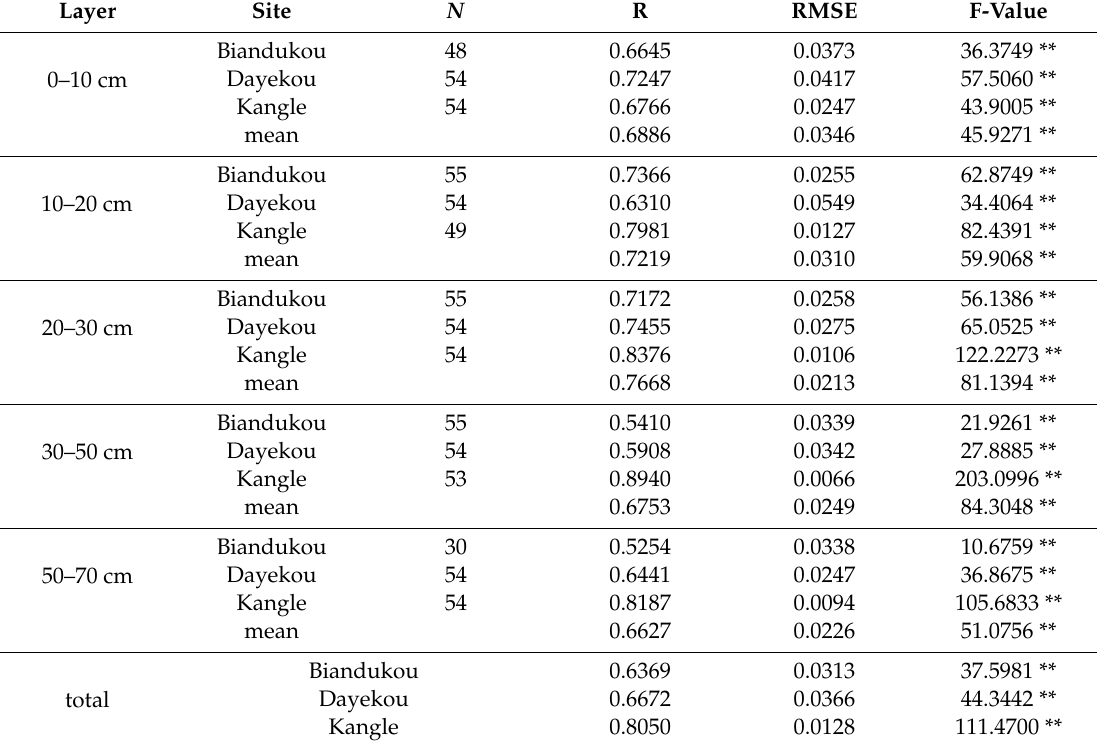
Table 3. Verification of the soil moisture upscaling equations at the three in situ observation